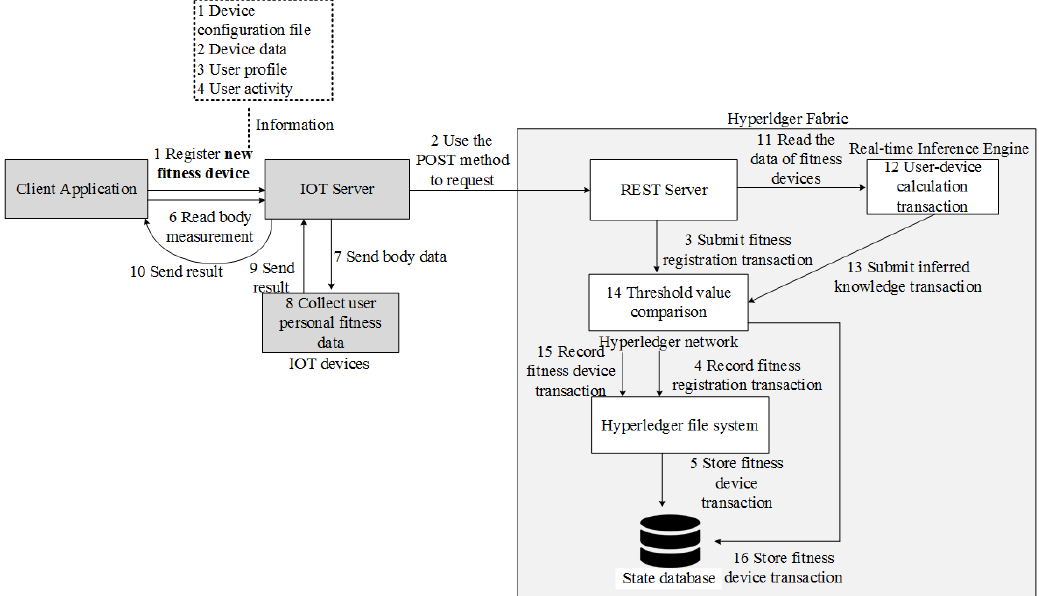
Figure 24. Reconstruction diagram of reference [51].